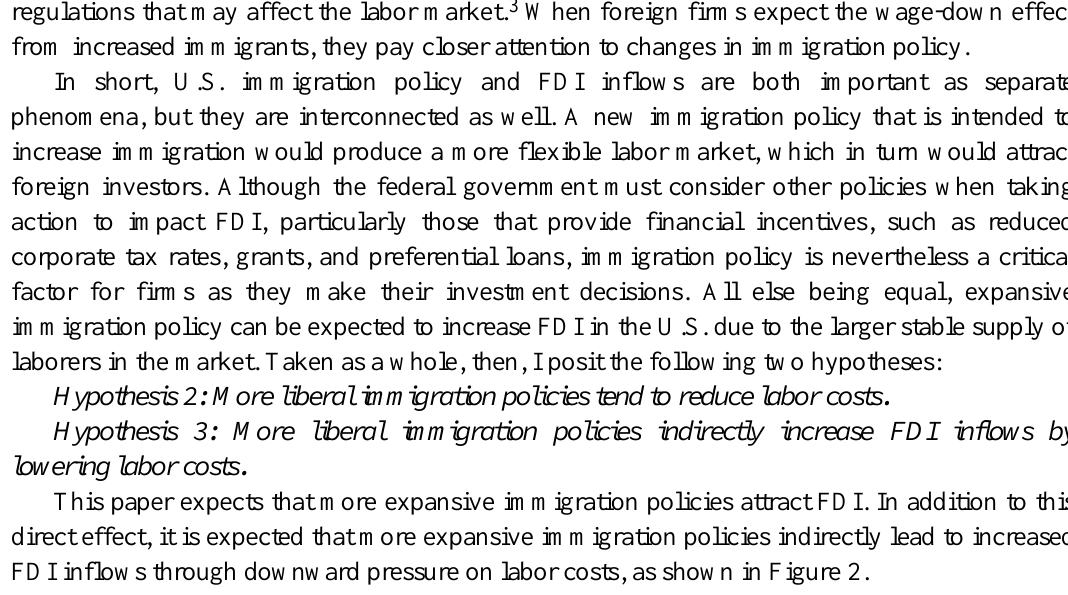
Figure 2: Conceptual Linkage between Immigration Policy and FDI